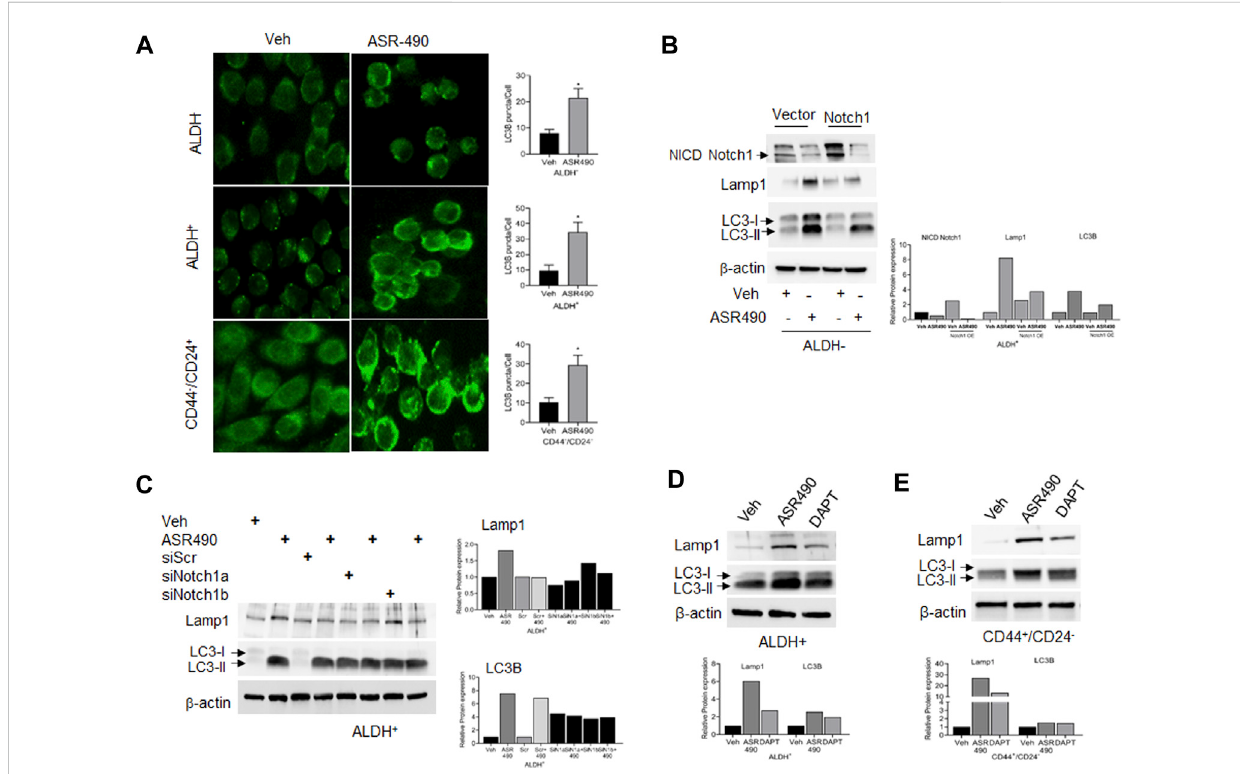
FIGURE 6 Notch-1 regulates autophagy in BCSC and BC cells. (A) Representative images of immuno fl uorescence analyses for LC3B punctae in vehicle and ASR490 treated ALDH − , ALDH + , and CD44 + /CD24 − cells. (B, C) Western blots for Lamp1 and LC3B expression in vehicle and ASR490-treated pCMV- and Notch1-transfected ALDH − cells (B) andSCR-siRNA,andNotch1-siRNA transfectedALDH + cells (C) . (D,E) Western blotsanalysisofNotch1-NICD, Lamp- 1, and LC3B for vehicle, ASR490, and DAPT-treated ALDH + and CD44 + /CD24 −